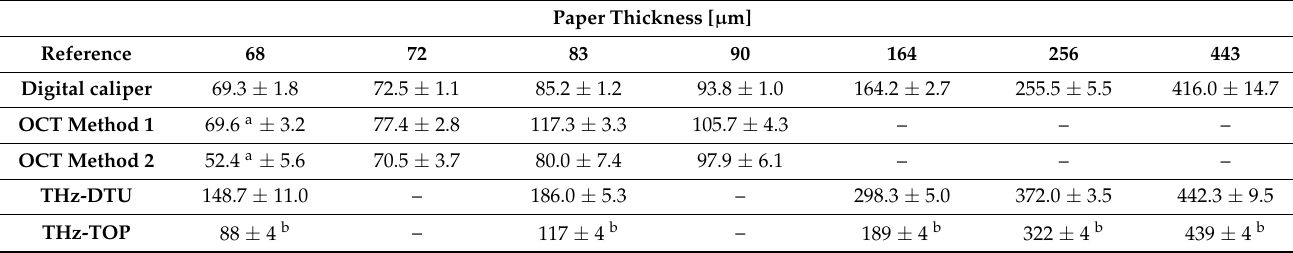
Table 1. Measured paper thicknesses using the digital caliper, OCT, and THz TDS compared to reference